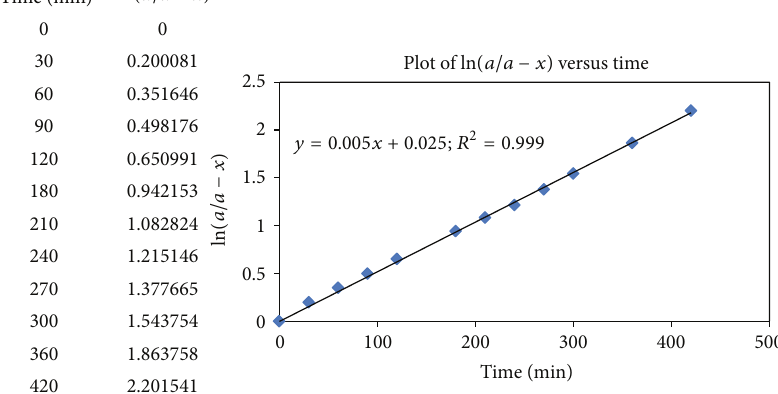
Figure 1: Pseudo first order kinetic plot of cinnamic acid (ln (𝐴 ∞ − 𝐴 𝑡 ) versus time) at 313 K. [CA] = 6.25 × 10 −3 moldm −3 ; [Phen] = 3.75 × 10 −3 moldm −3 ; [Fe(III)] = 1.25 × 10 −3 moldm −3 ; [PEG-200] = 9.37 × 10 −1 moldm −3 .